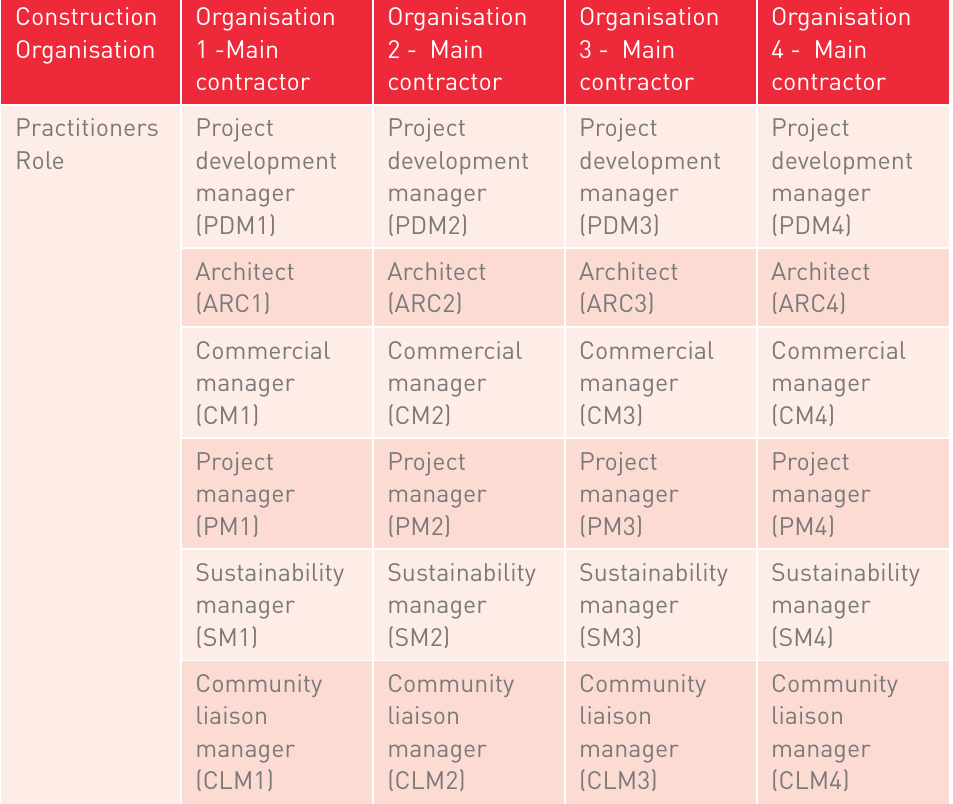
The profiles of interviewees